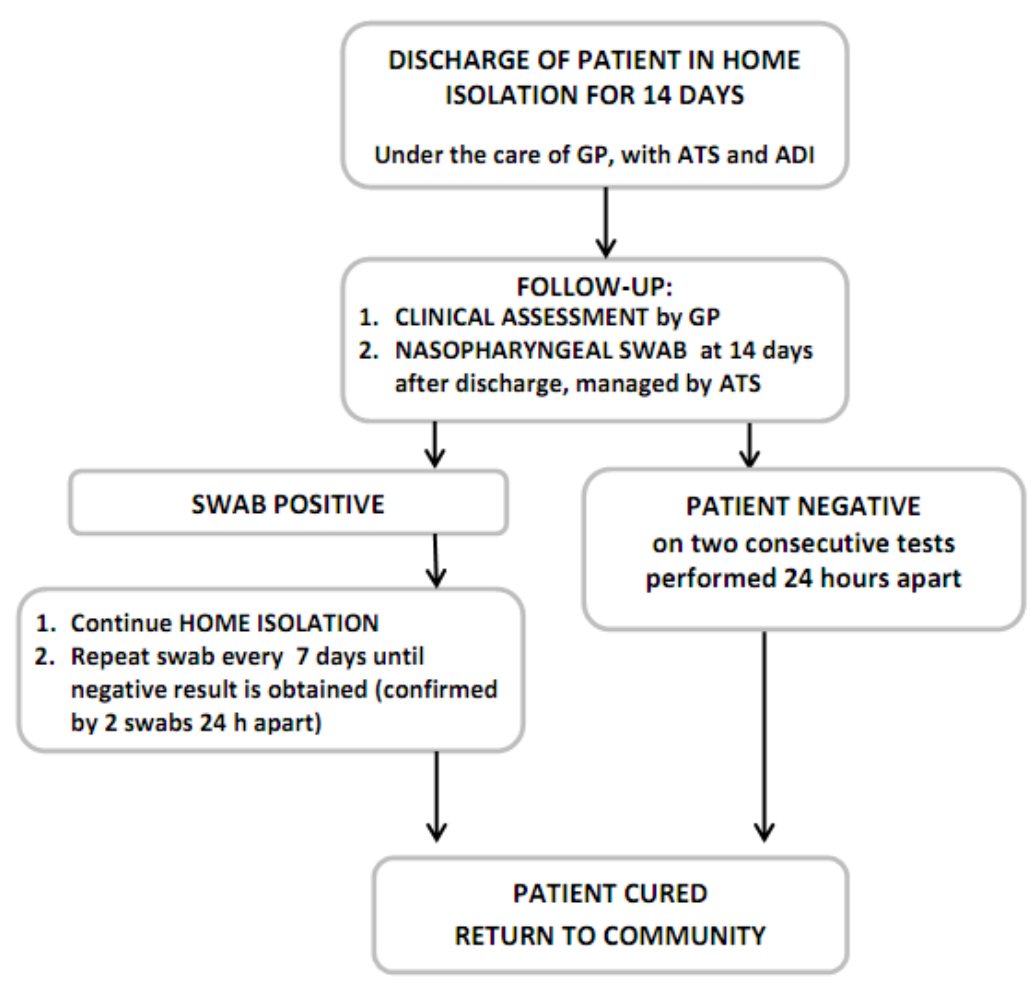
Figure 6. Flowchart showing the management of swab tests.